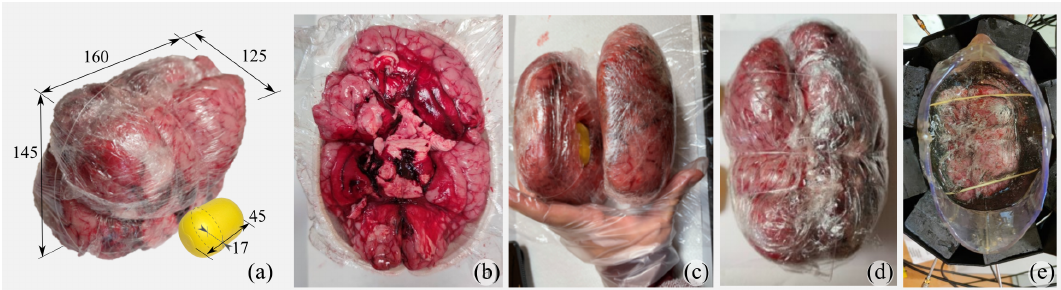
Figure 3. Multi-tissue phantom (MTP): ( a ) brain and stroke phantom (dimensions in mm), ( b ) one hemisphere preparation, ( c ) two hemispheres with inserted stroke, ( d ) joined brain, and ( e ) head phantom with immersed brain and filled up with electrically fat-mimicking